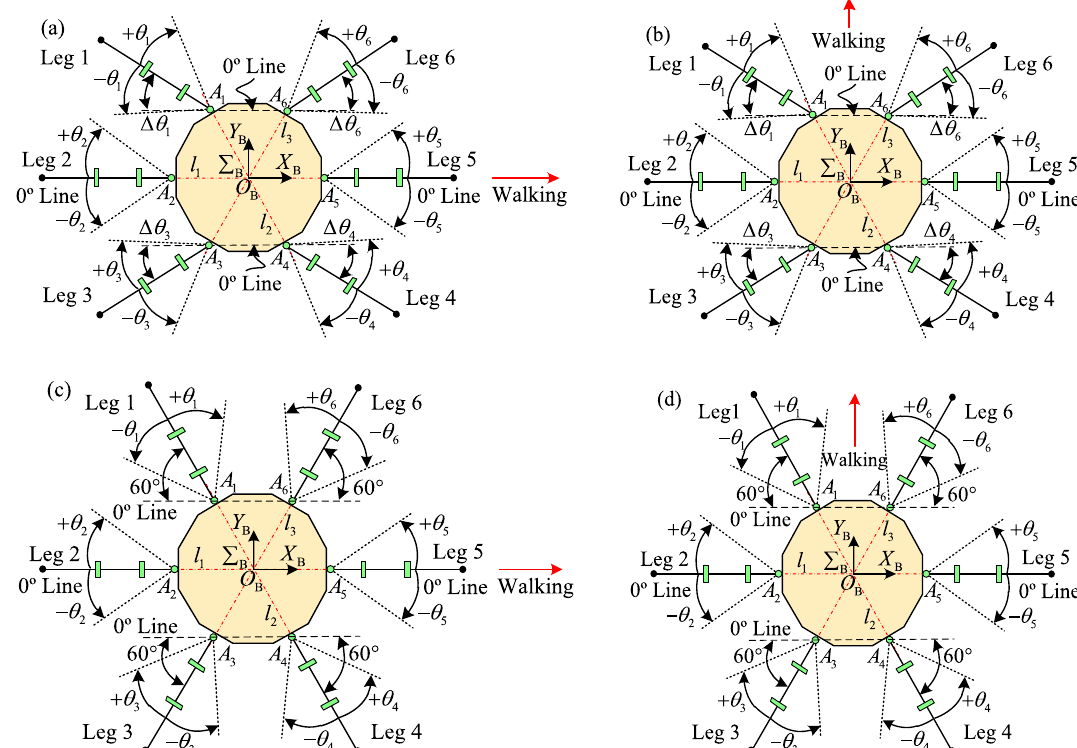
Figure 3 Typical walking modes of large-load-ratio six-legged robot [26]: (a) Crab type, (b) ant type, (c) mixed type I, and (d) mixed type